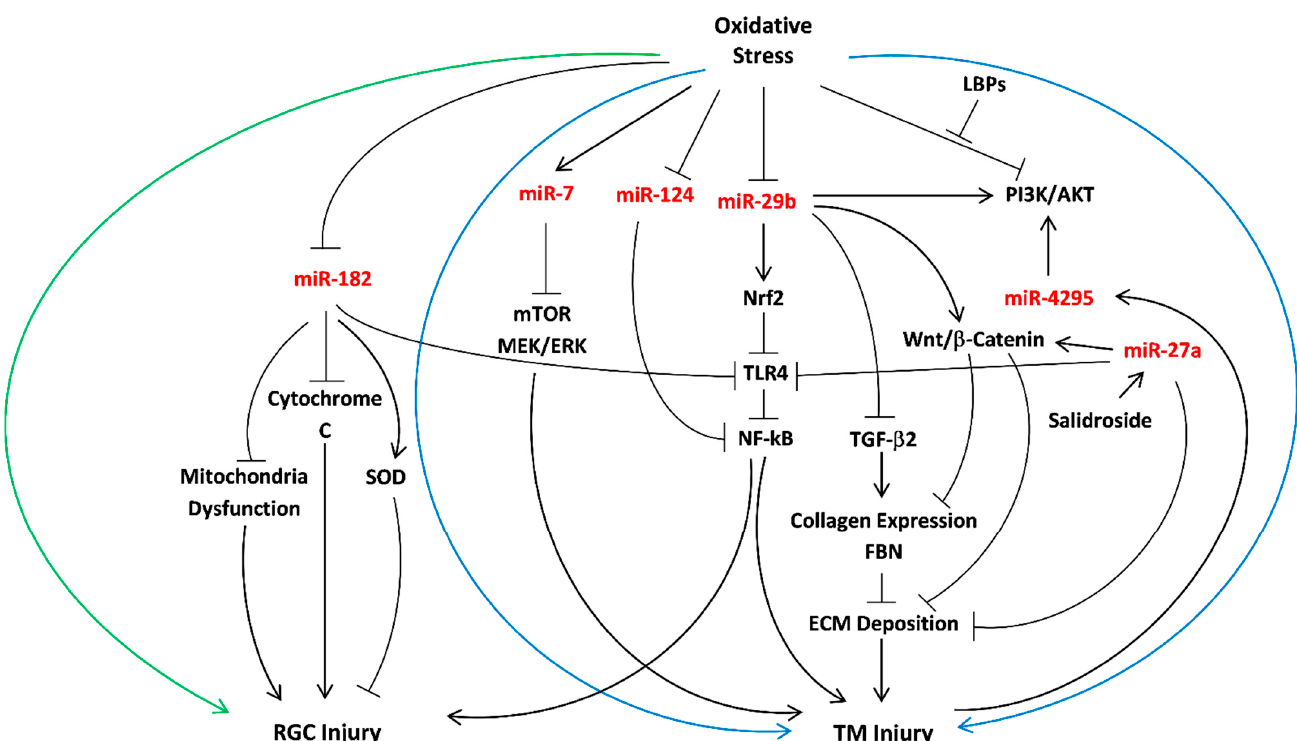
Figure 1. Overview of important miRNAs as mediators of oxidative stress in POAG. Summary of the miRNAs (red) involved in the protective mechanisms against oxidative stress in POAG. miR-7, miR-24, miR-27a, miR-29b, miR-4295 have an anti-oxidant effect in TM cells (surrounded by the blue arrows), while miR-182 reduces oxidative stress damage in RGC (surrounded by the green arrow). The following abbreviations refer to TM (trabecular meshwork), RGC (retinal ganglion cells), LBPs ( Lycium barbarum polysaccharides), FBN (fibrillin), ECM (extracellular matrix), SOD (superoxide dismutase), TGF- β 2 (transforming growth factor-beta 2), NF-kB (nuclear factor kappa-light-chain-enhancer of activated B cells), TLR4 (toll-like receptor 4), and Nrf2 (nuclear factor erythroid 2-related factor 2).